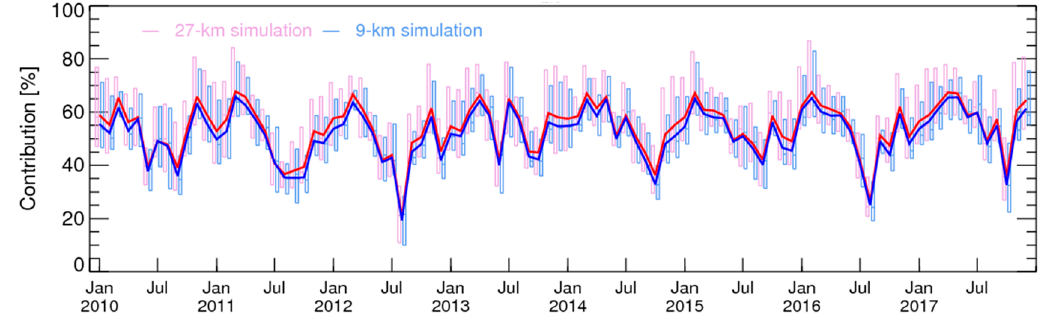
Figure 6. The monthly Chinese contribution to the PM 2.5 concentrations of 17 provinces. The solid lines depict the average Chinese contribution.